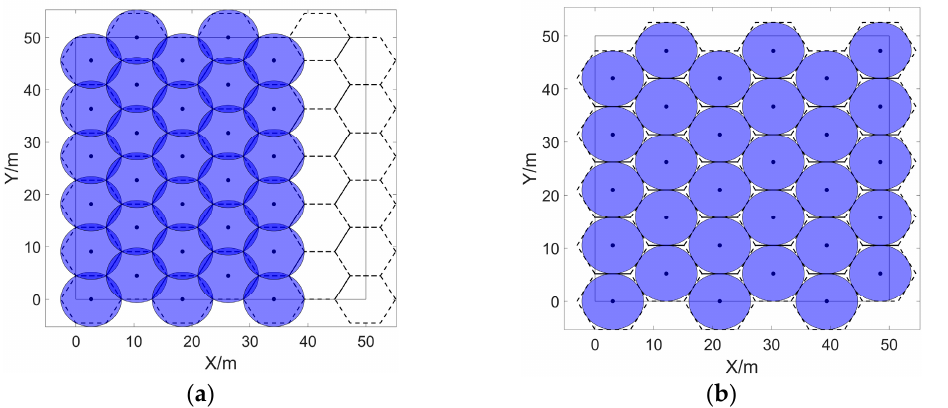
Figure 6. Coverage effects of sensors. ( a ) The sensing area is incompletely covered, and 12 cellular grids become the monitor blind area when the condition N S < N ub is satisfied and the radius of cellular grids is not adjusted. ( b ) The problem of the monitoring blind area is effectively improved by adjusting the radius of cellular grids.